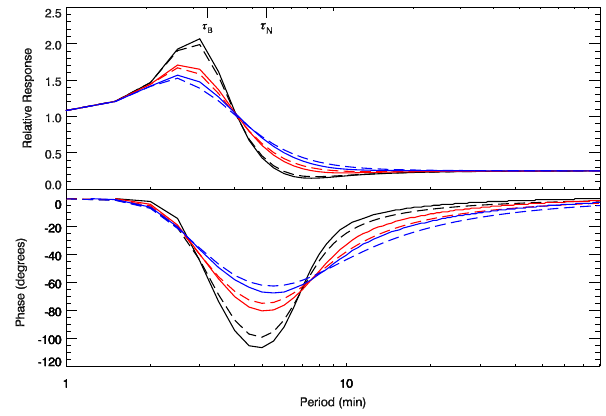
Fig. 2. Comparison of the analytical solution (dashed) with the nu- merical solution (solid) for the response of a 12m diameter SPB to gravity waves with different values of vertical velocity amplitude and periods of 15min (blue), 30min (red) and 60min (black). The top panel shows the balloon displacement normalized to wave dis- placement ( ζ 0 o /ζ o ) and the bottom panel the relative phase, φ .